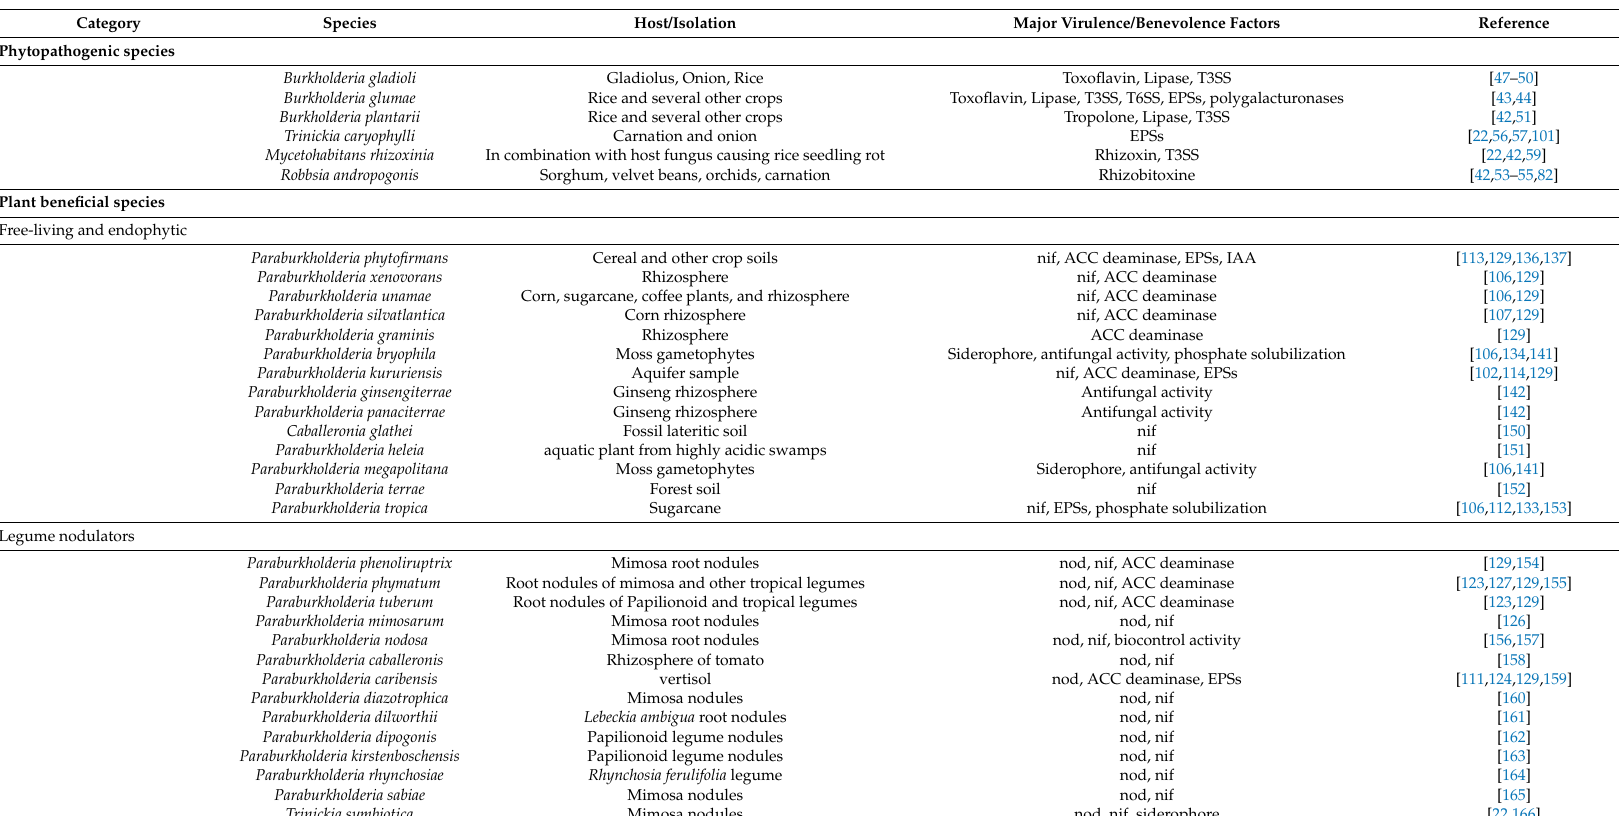
Table 3. A list of the main Phytopathogenic and plant-associated beneficial Burkholderia species, their major virulence or benevolence factor, and host or isolation sources.